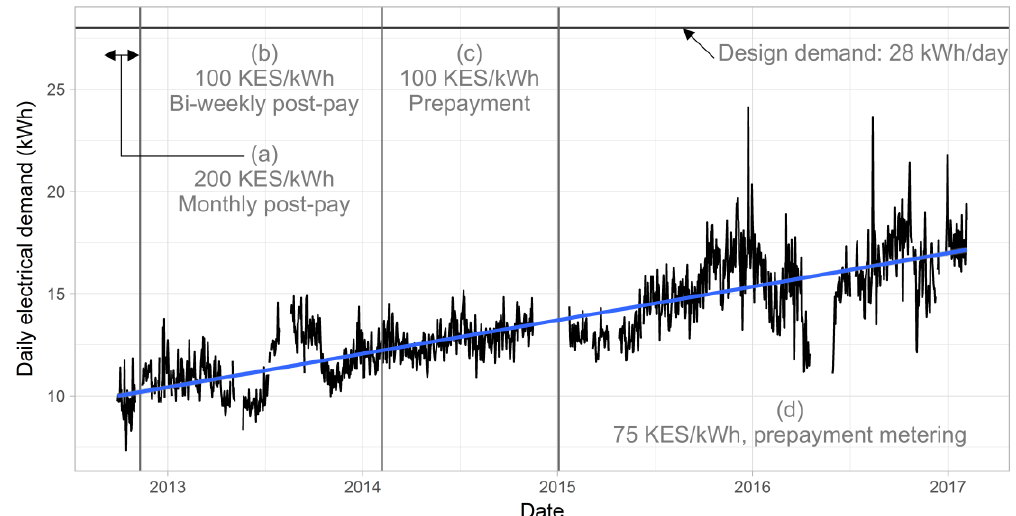
Figure 8. Details of the Kitonyoni kWh tariff charged by the co-operative; payment collection method and impacts on the consumption over the periods (a) to (d) end Sep 2012 to end of Jan 2017. Gaps correspond to no recorded data due to issues with data logging equipment.